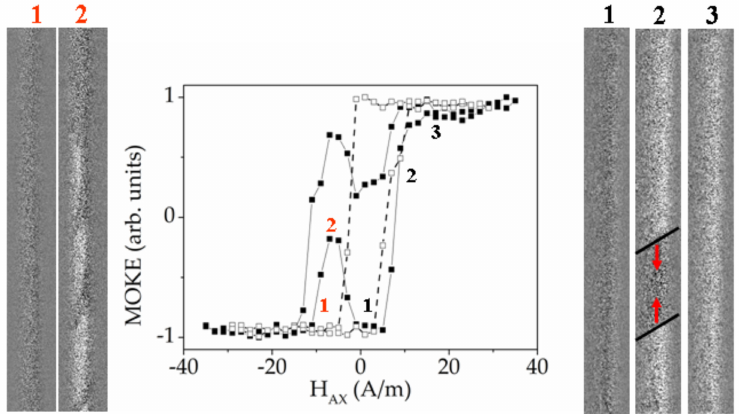
Figure 16. MOKE hysteresis loops and images of surface domain structure obtained in annealed sample № 5 (black points) and as-prepared sample № 5 in the presence of torsion stress of 1 π rad m − 1 (white points).